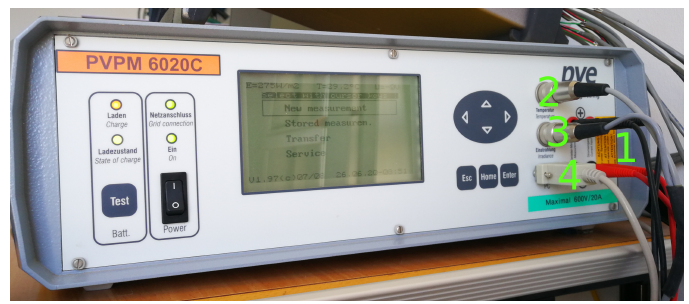
Figure 2. I–V curve tracer, including the PV-Engineering model PVPM-6020C used in the Univer- sidad de Almería. Connection elements: (1) Two four-wire measuring connectors for voltage and current, respectively; (2) input for external Pt100 (module back surface temperature measurement); (3) irradiation input; and (4) RS-232 serial interface to the